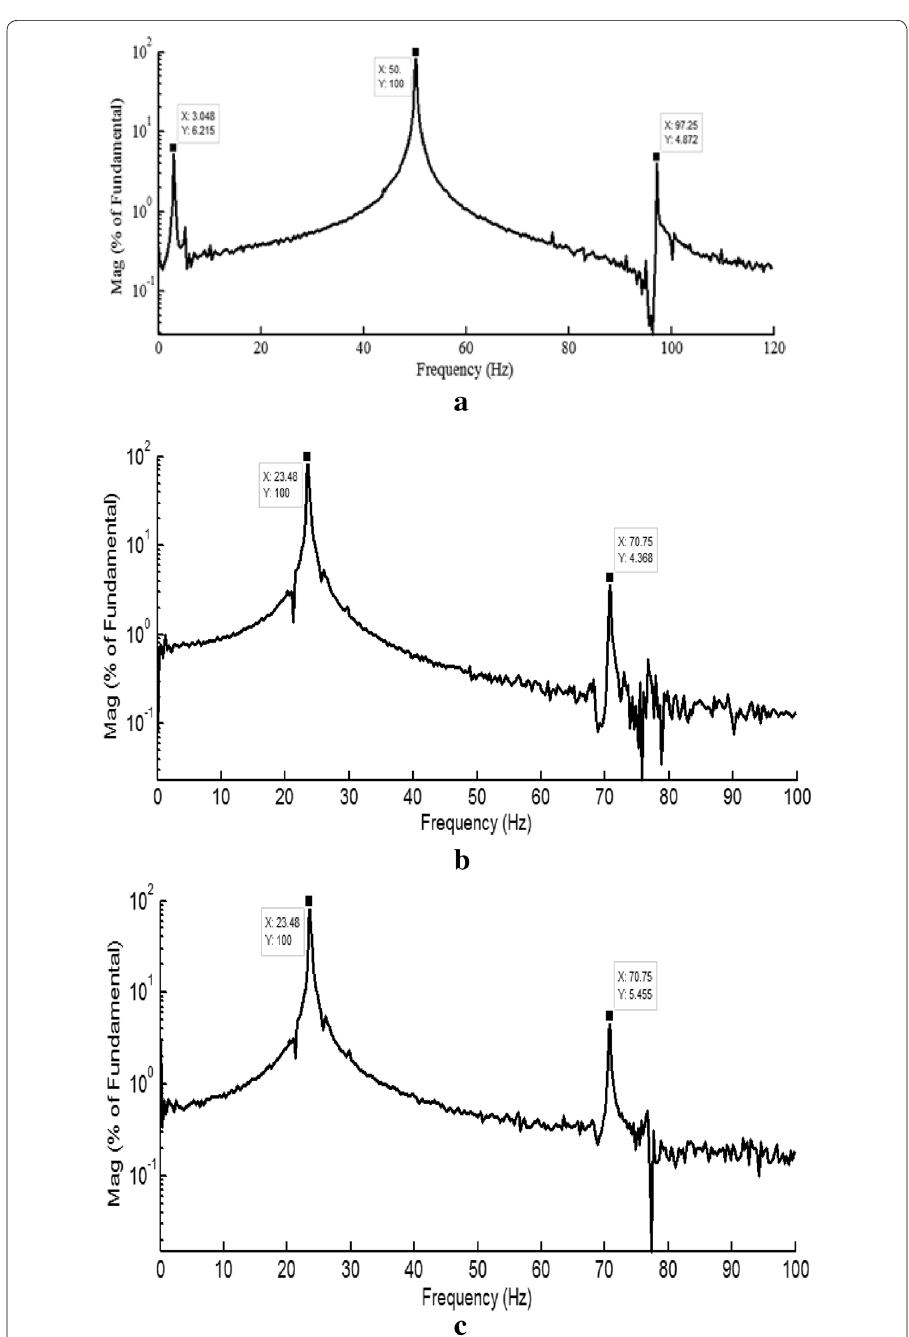
Fig. 13 Current spectrums for standard delta connection with internal open circuit, a stator phase current, b rotor (phase‑ar) current and c rotor (phase‑br)